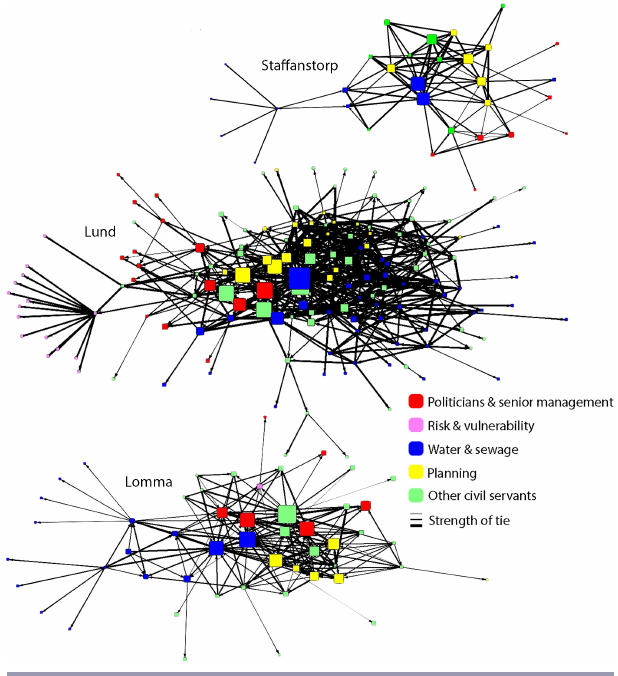
Fig. 3 . Control over resource flows in networks of actors mitigating flood risk within the three studied municipal administrations. Node size = control over resource flows (directional betweenness centrality). Tie thickness = normalized sum of importance of inputs. Note that node sizes and tie thicknesses are relative within each network and cannot be compared between networks.